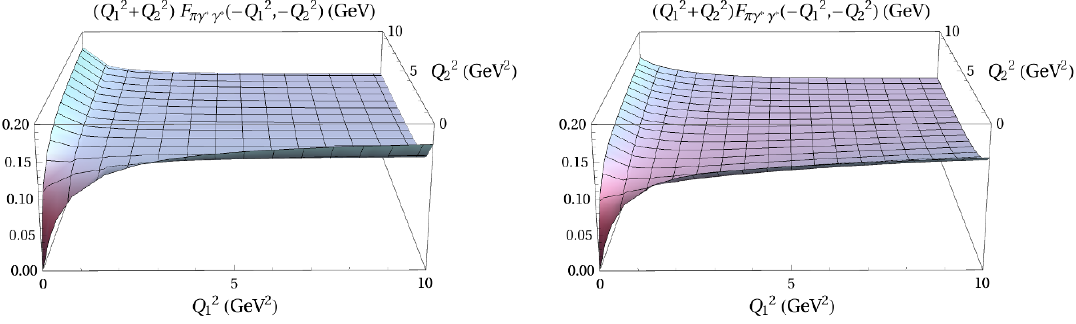
; Q 2 < 10 GeV 2 . The large- N c Regge 1 2